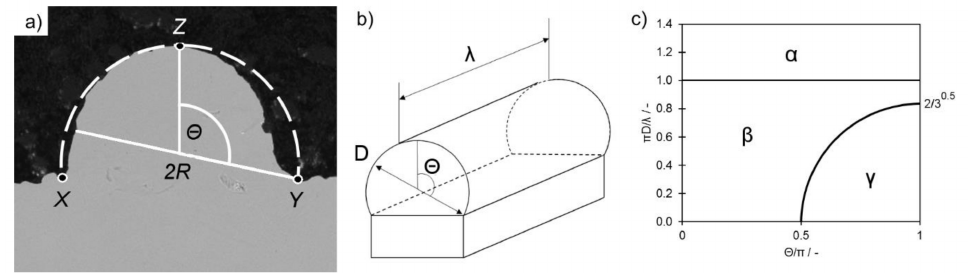
Figure 5. ( a ) Scheme of semi-cylinder measurement; ( b ) overview of the semi-cylinder approximation and ( c ) map of liquid cylinder stability. Based on Gusarov and Smurov